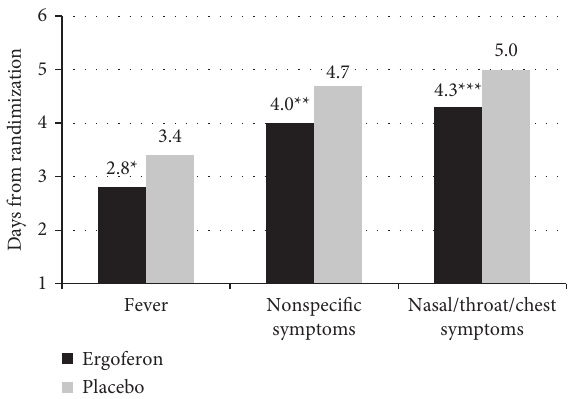
Figure 3: Time to alleviation of fever, nonspecific symptoms, and nasal/throat/chest symptoms. The duration of the main ARI symptoms in the Ergoferon group was significantly less in